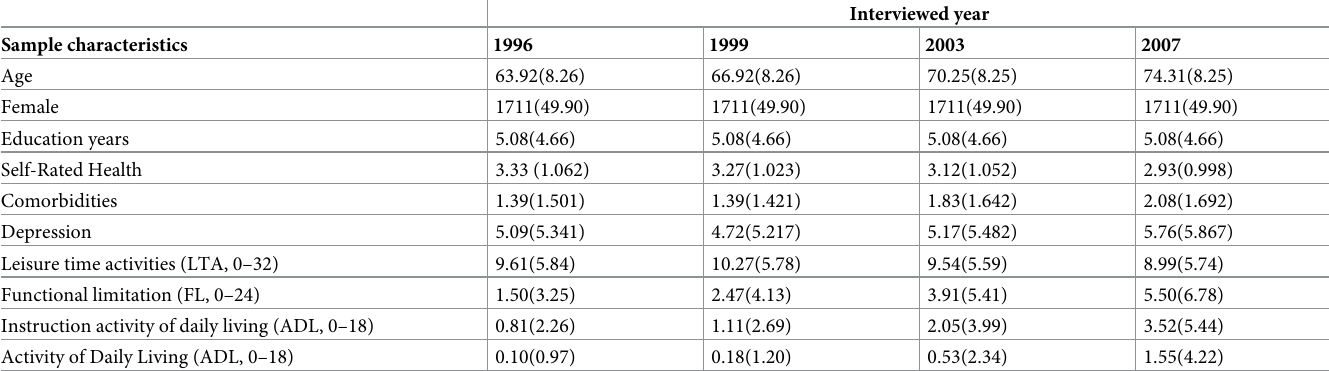
Table 1. Characteristics of the sample responding in each wave ( N =